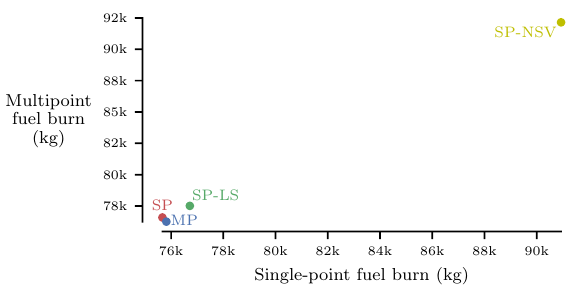
Figure 13. Optimizing for robust performance in cruise and climb incurs fuel burn.